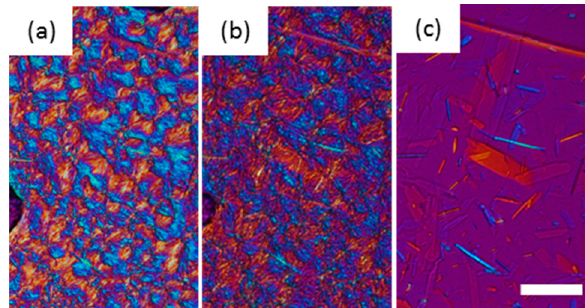
Figure 7. The morphological changes and melting behavior of β 3 α after heat treatment at 44 °C for 12 hours. ( a ) 44 °C, ( b ) 45.2 °C, and ( c ) 45.5 °C. The scale bar is 50 μ m. 12 h. ( a ) 44 ◦ C, ( b ) 45.2 ◦ C, and ( c ) 45.5 ◦ C. The scale bar is 50 µ